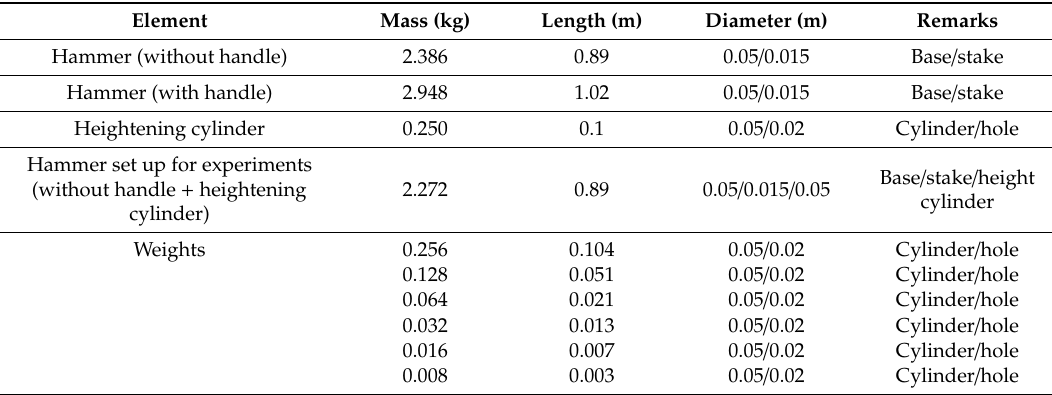
Table 1. Characteristics of the devices used for the